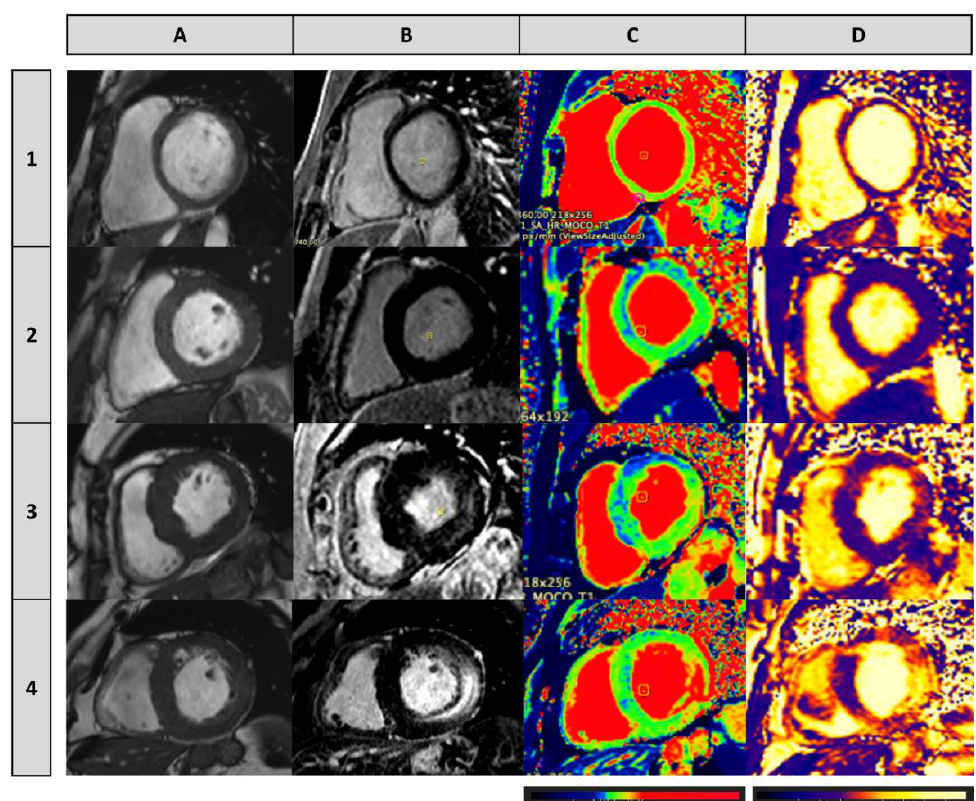
Figure 2. Cardiac magnetic resonance imaging (MRI) (3.0 Tesla) in four Fabry patients, illustrating different stages of myocardial involvement by the disease. ( A ) Cine (balanced steady-state free precession sequence) image at the basal left ventricular (LV) short-axis slice; ( B ) Late gadolinium enhancement (LGE) at the basal LV short-axis slice; ( C ) Native T1 mapping (precontrast) performed using a modified Look-Locker inversion (MOLLI) recovery sequence at the basal LV short-axis slice (the resulting pixel-by-pixel T1 color maps were displayed using a customized lookup table, in which normal myocardium was green, increasing T1 was yellow and red, and decreasing T1 was blue); and ( D ) T2 mapping (fast low angle shot (FLASH)) at basal LV short-axis slice (the resulting pixel-by-pixel T2 color maps were displayed using a customized lookup table, in which normal myocardium was purple and increasing T2 was red and yellow). Patient 1: A 26-year-old female without LVH or LGE, presenting normal values of T1 (1265 ± 68 ms at the basal septum) and T2 (41.76 ± 5.40 ms at the basal septum); Patient 2: A 41-year-old male without LVH or LGE, presenting low T1 (1118 ± 40 ms) and normal T2 (40.93 ± 5.80 ms) values at the basal septum; Patient 3: A 76-year-old female with LVH (LV mass 83 g/m 2 , maximum wall thickness 19 mm at the basal septum) and diffuse LGE in the basal segment of the inferolateral wall, who presents low T1 (1093 ± 36 ms) at the basal septum and T1 pseudonormalization particularly at the inferolateral wall (1276 ± 59 ms), where a mild increase in T2 values (49.10 ± 2.30 ms) was also observed; Patient 4: A 69-year-old male patient with LVH (LV mass 123 g/m 2 , maximum wall thickness 18 mm at the septum) and diffuse and extensive LGE in the inferolateral wall, who presents areas of T1 pseudonormalization but also areas of T1 increase, such as in the inferolateral wall (1425 ± 144 ms), where T2 values (64.44 ± 8.56 ms) are also increased.